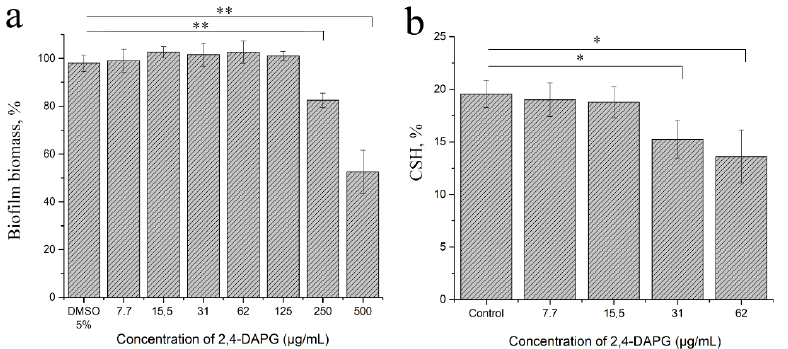
Figure 4. Total biomass quantification (crystal violet) assay was applied for estimation of the adhesion efficacy within 1.5 h ( a ). Adhesion to polystyrene and cellular surface hydrophobicity (CSH) of C. albicans ATCC 10231 cells ( b ). The means plus standard deviations of results from two independent experiments with three technical replicates are shown. Values that are significantly different from the values for “DMSO 5%” or “control” are indicated * p < 0.05, ** p < 0.01 (pair-sample Student’s t -test).